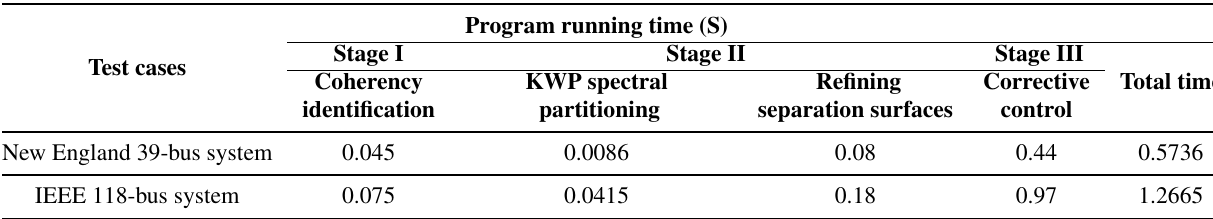
Table 7. The computational time of test cases. KWP: k-way